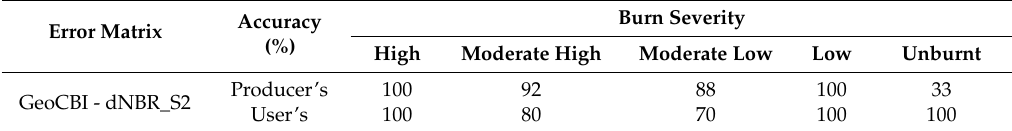
Table 5. Producer’s and User’s accuracy percentage values by burn severity categories and for the single combination of ground-based burn index (GeoCBI) and reflectance-based dNBR index derived from Sentinel-2A (dNBR_S2). See Table S1 for categories and ranges of the ground-based burn severity index, File S1 for details on error matrix, and Figure 3 for categories and thresholds of the dNBR index.